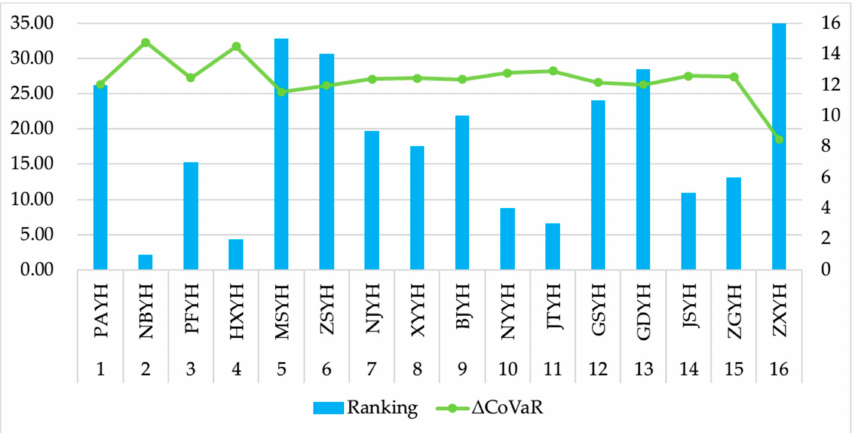
Figure 15. Measurements and rankings of dynamic ∆ CoVaRs (overall analysis, extreme circumstance) (The left axis and right axis refers to the value and ranking of the dynamic ∆ CoVaR (the di ff erence between the Conditional Value at Risk (CoVaRs) when the bank is in distress and in a normal state) of each